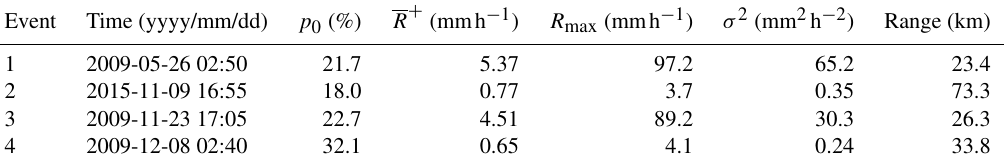
Table 1. Summary statistics for the four example events, namely time; proportion of zero rainfall values p 0 ; average rainfall intensity R (given occurrence); maximum rainfall intensity R max ; variance σ 2 of the rainfall intensity field (given occurrence).